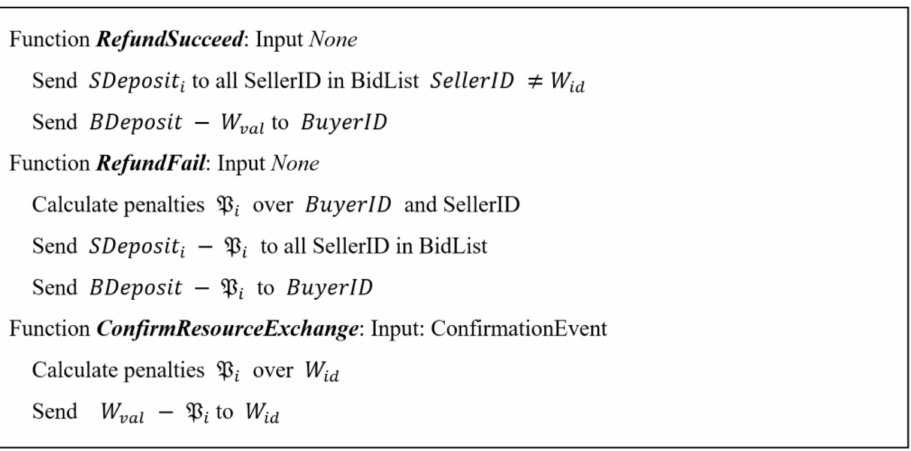
Figure 6. Resource trading, third phase: Payment and resource delivery